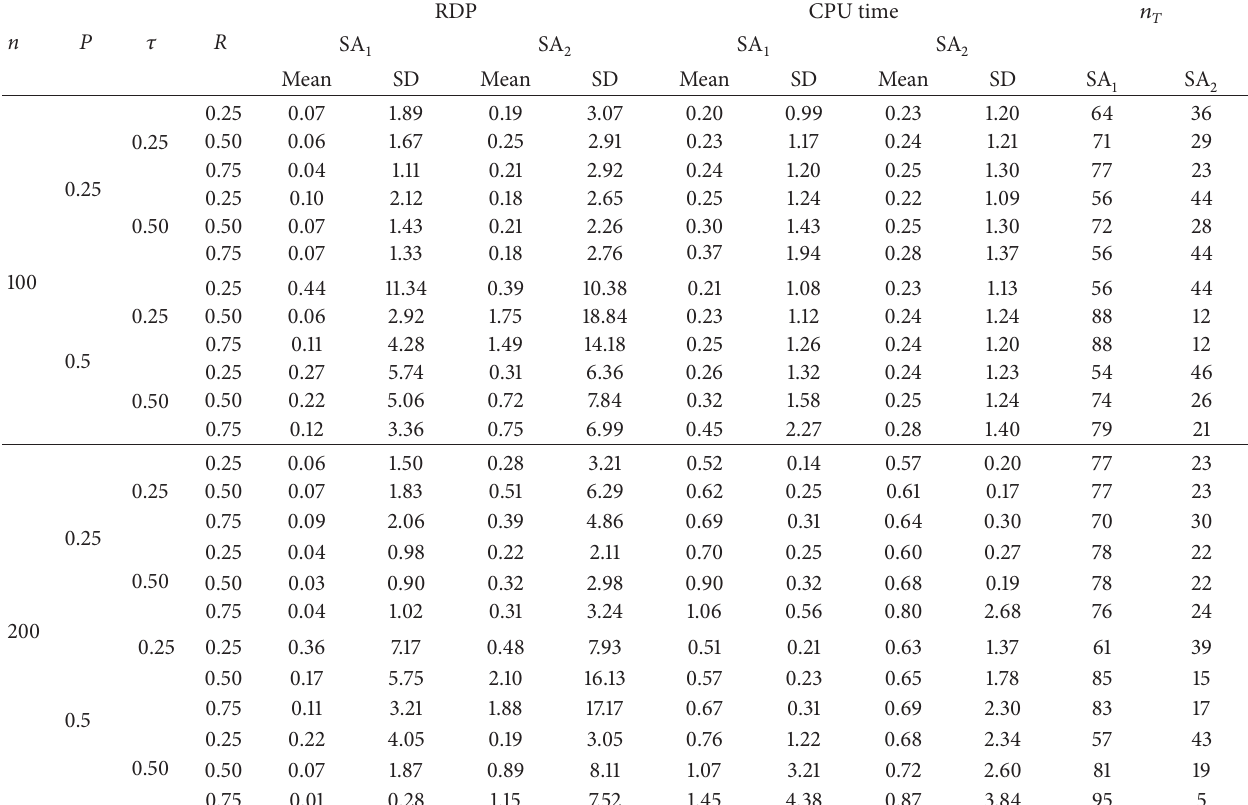
Table 6: The performance of the SA 1 and SA 2 algorithms with 𝜃 = 0.5